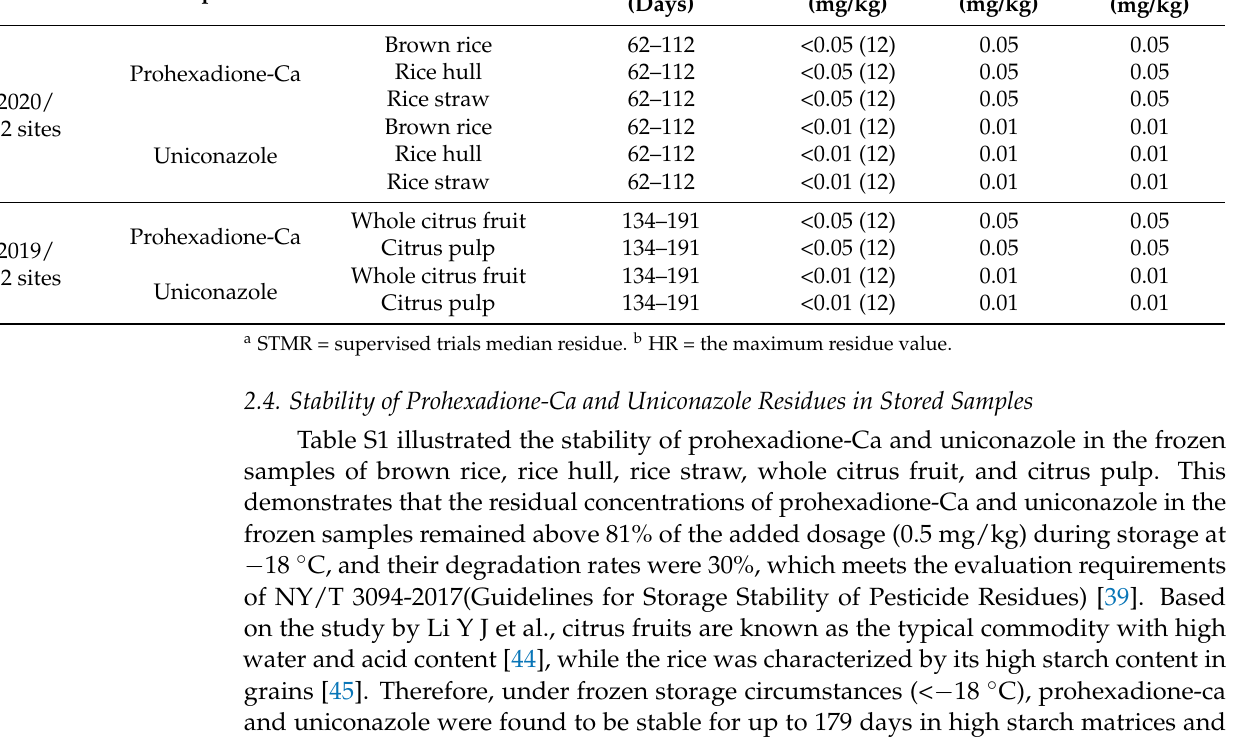
Table 2. The residues of prohexadione-Ca and uniconazole on rice and citrus. Compounds